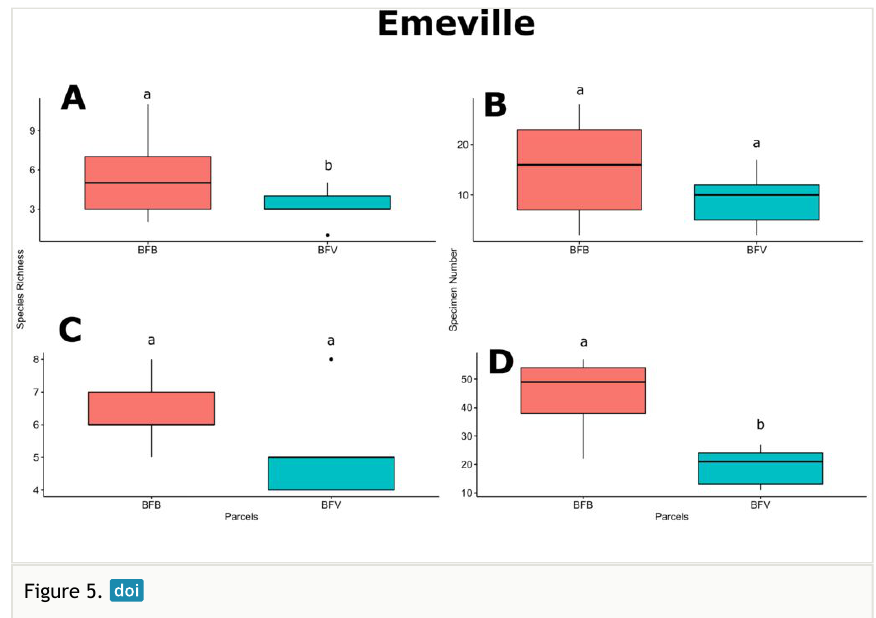
Figure 5. Mean values of species richness and abundance for bee and hoverfly fauna amongst flower strips BFB and BFV (see details given in Table 1). A. Bee richness; B. Bee abundance; C. Hoverfly richness; D. Hoverfly abundance. Letters above the boxplots represent Student t-test